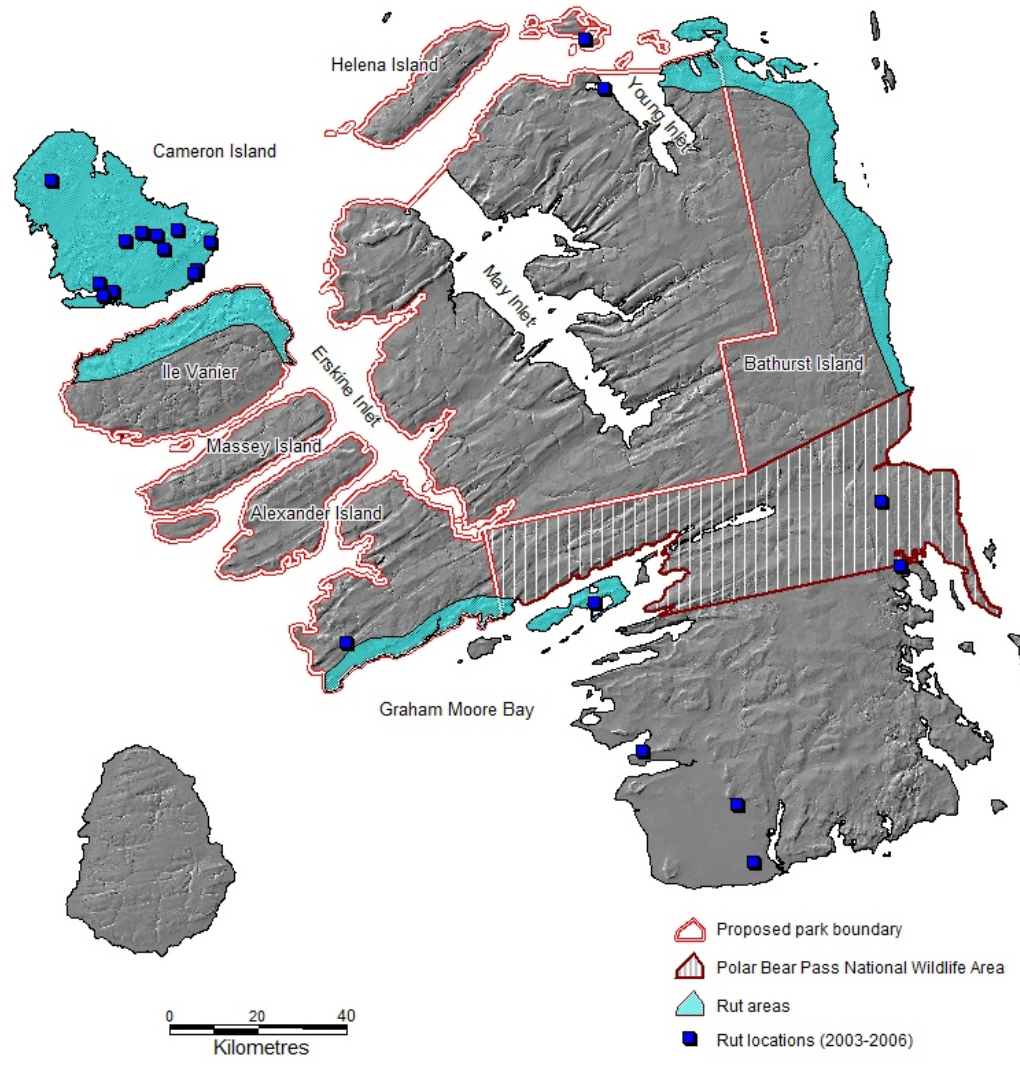
Figure 5. Rutting areas as obtained from 2003–06 collared cow Peary caribou. Shaded “rut areas” are from Miller